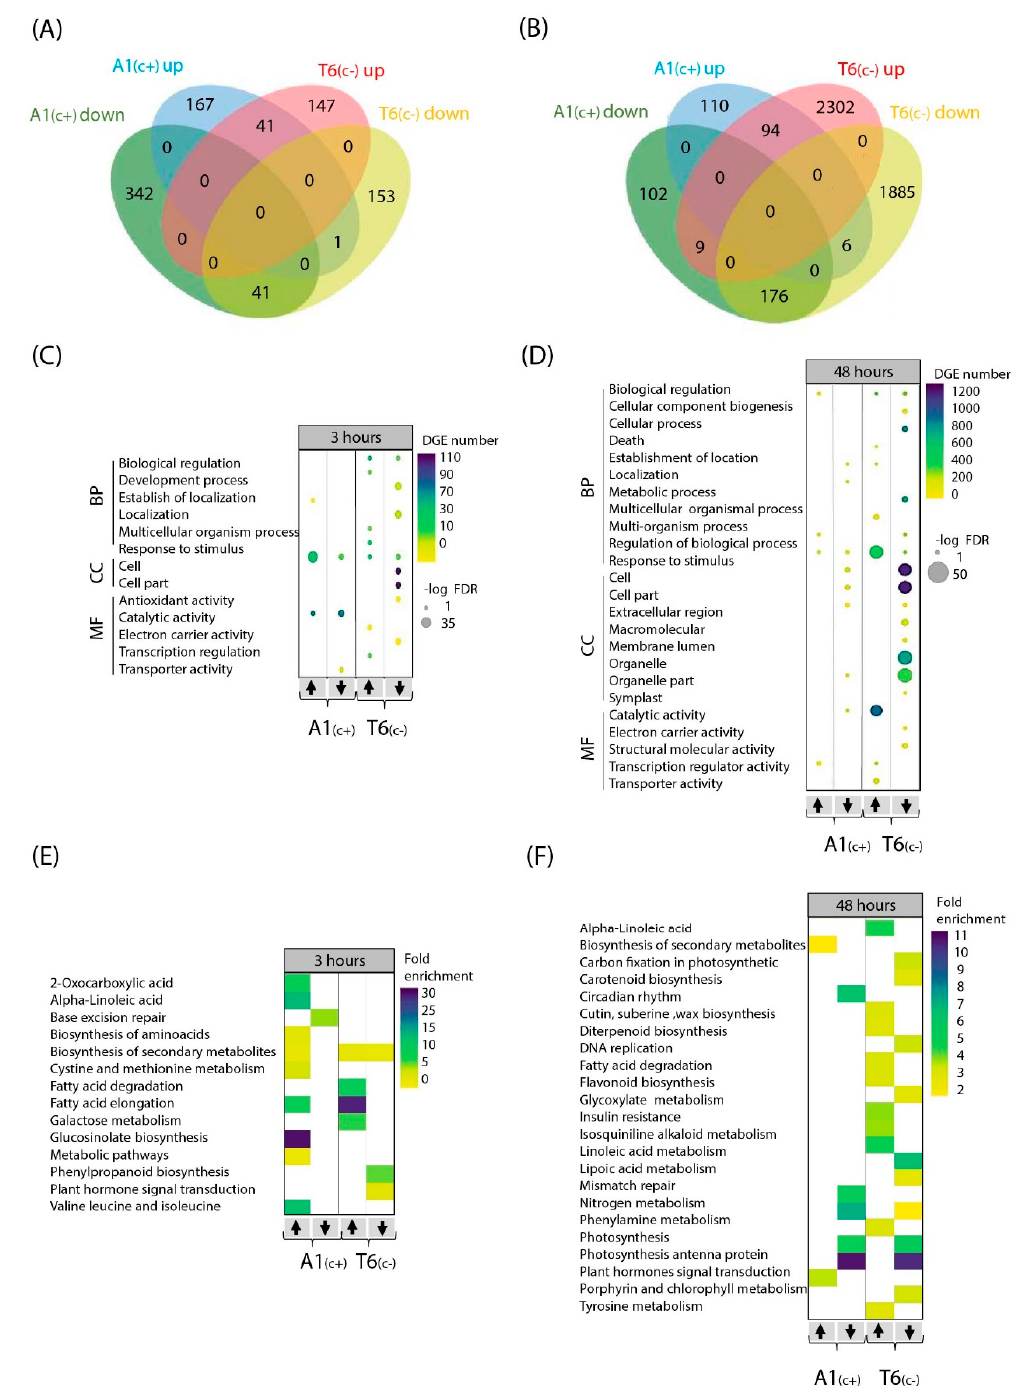
Figure 3. Gene Ontology (GO) and Kyoto Encyclopedia of Genes and Genomes (KEGG) pathway of bic vs. pH 5.9 treatments DEGs at two time points. Venn diagram of up- and downregulated DEGs in A1 (c+) and T6 (c − ) comparing bic vs. pH 5.9 treatments after 3 h ( A ) and 48 h ( B ). Bubble plots indicating significant GO analysis of differentially expressed genes in bic vs. pH 5.9 comparison between A1 (c+) and T6 (c − ) at 3 h ( C ) and 48 h ( D ). GO were filtered to adjusted p -value < 0.05. Scale colors indicate number of DEGs while bubble size indicates -log of adjusted p -value. GO terms were separated into biological function, cellular component, and molecular function. Arrows indicate up or downregulated genes. Heatmaps of KEGG pathway analysis from DEGs in bic 8.3 vs. pH 5.9 comparison between A1 (c+) and T6 (c − ) at 3 h ( E ) and 48 h ( F ). KEGG pathway terms were filtered by p -value < 0.05. Scale colors indicate pathway fold enrichment. BP, biological process; CC, cellular component; MF, molecular